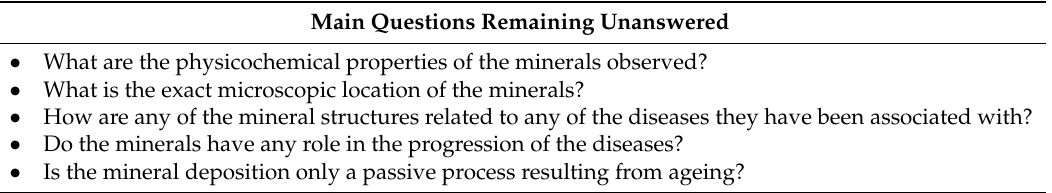
Table 6. List of main questions that remain unanswered in relation to brain